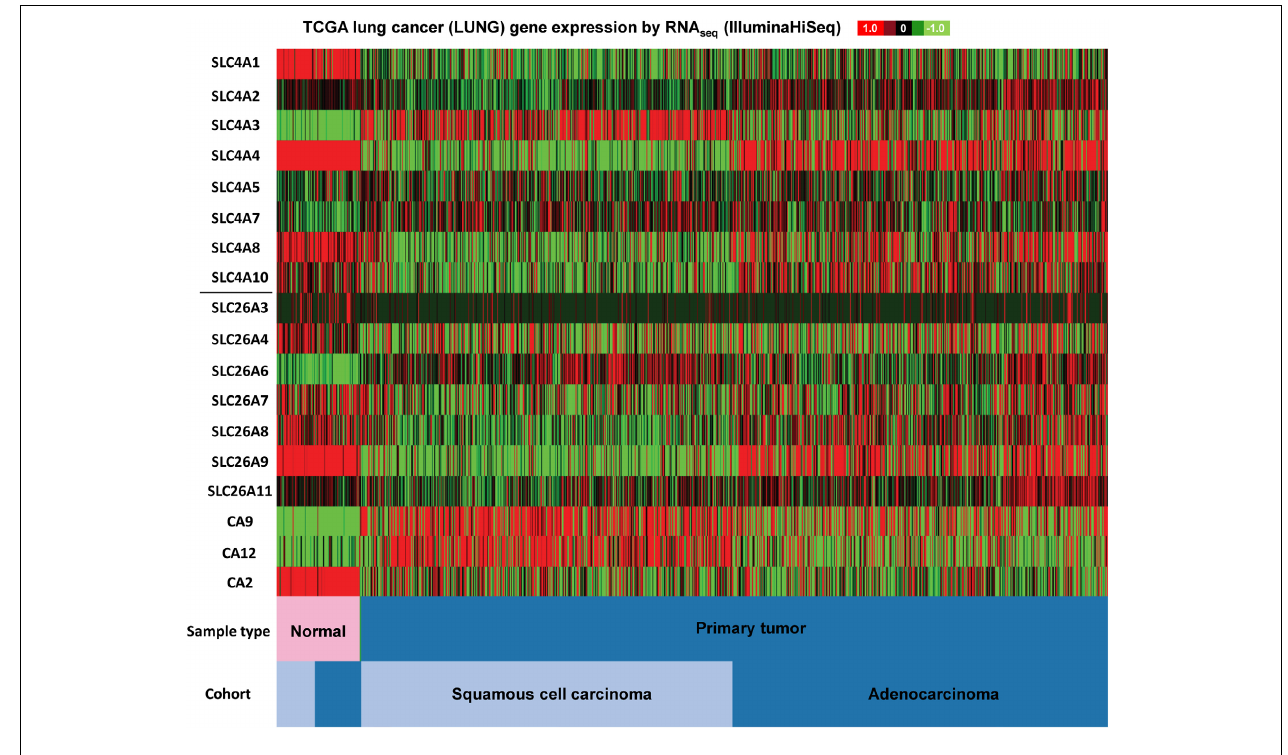
FIGURE 3 | SLC4 and SLC26 family mRNA expression levels in lung cancer. RNA sequencing data (ID: TCGA_LUNG_exp_HiSeqV2, N = 1081) from The Genome Cancer Atlas database was processed and visualized with UCSC Cancer Genomics Browser (https://genome-cancer.ucsc.edu). The